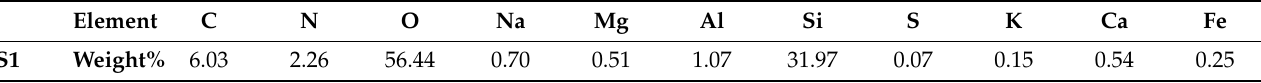
Figure 5. ( a ) SEM of the clinker brick (sample S1); ( b ) EDS of the clinker brick (sample S1); the inset image is the collecting point. Table 2. Elemental composition from EDS spectra of the clinker brick (sample S1).